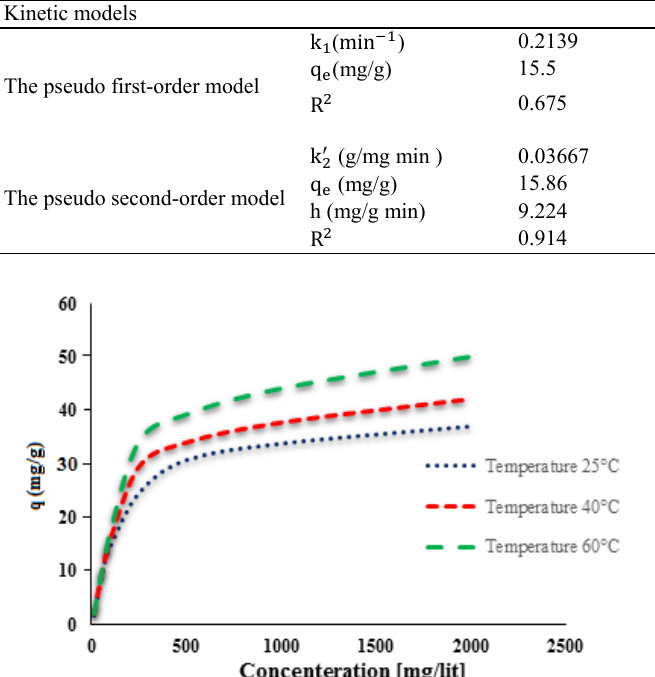
Table 1. Kinetic parameters for Cd(II) sorption by modified zeolite Kinetic models